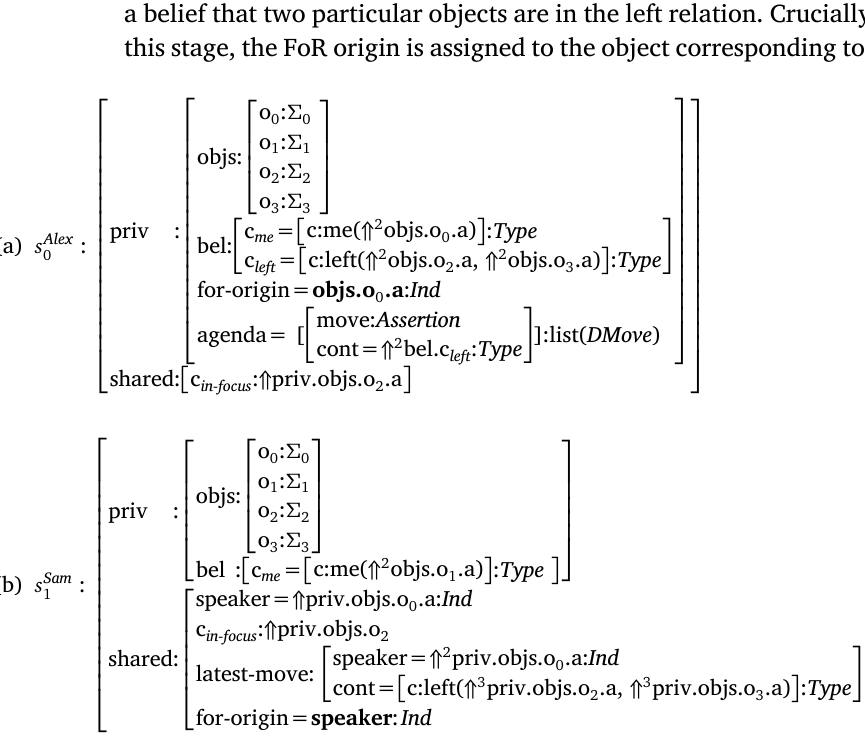
Figure 11: Types of dialogue information